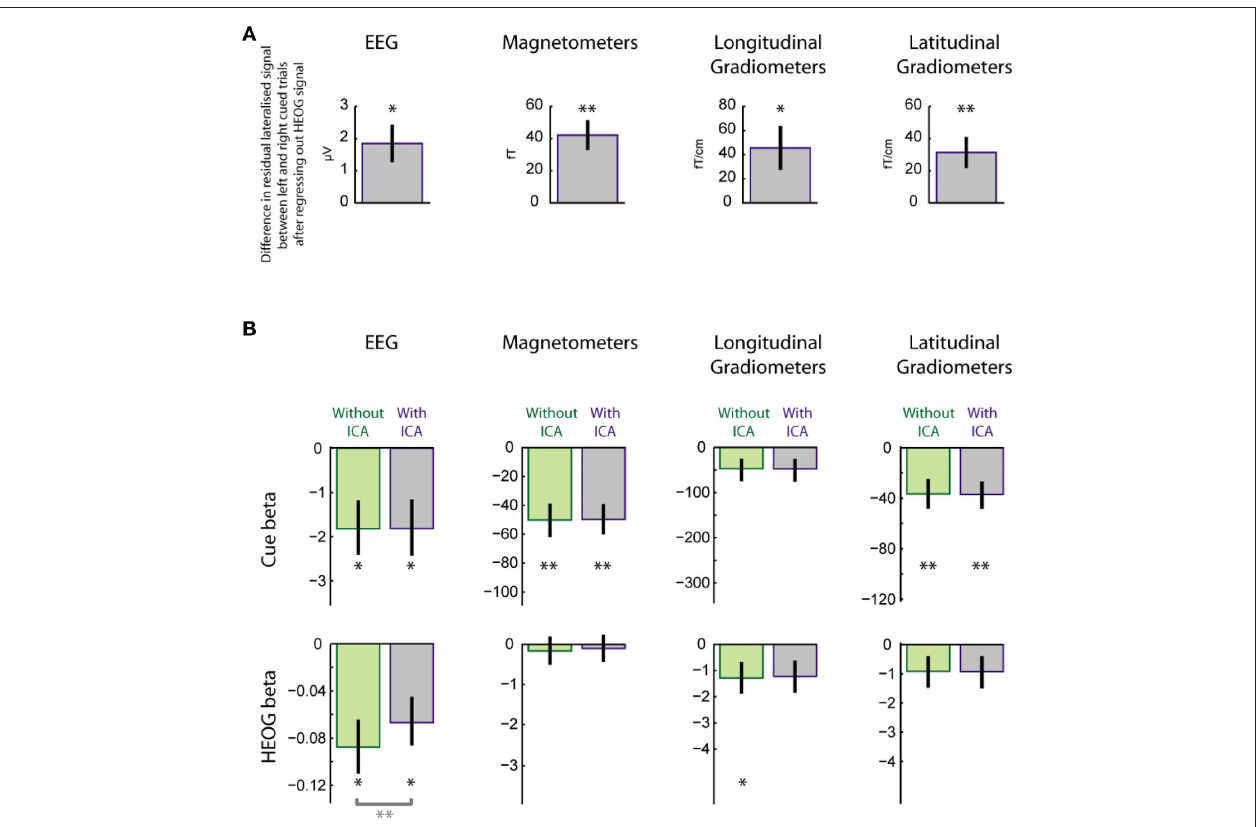
Figure A6 | effects of cue remain after accounting for differences in HeOg signal. (A) Difference in residuals, between left-cued and right-cued trials, after regressing left-lateralized signal on HEOG signal. (Data averages set-sizes four to six within 290–530 ms across the same electrodes and magnetometers plotted